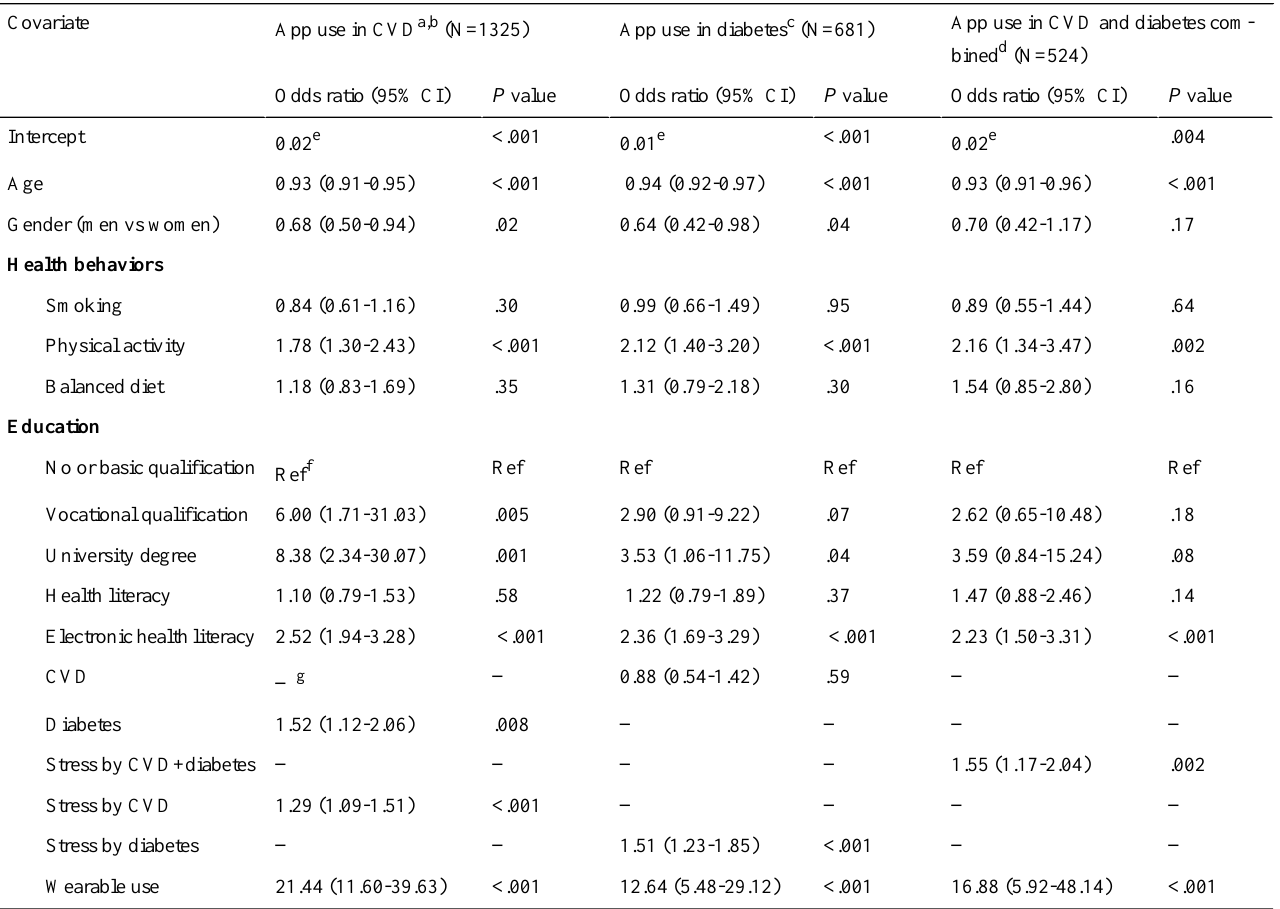
Table 3. Multivariate associations with app use.